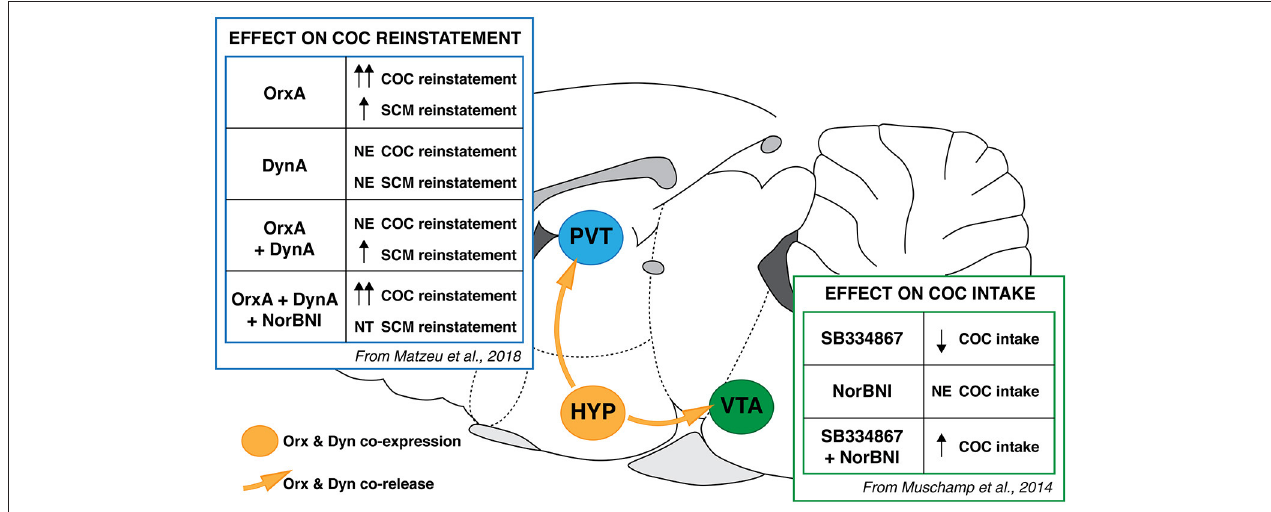
FIGURE 3 | Schematic summary of Orx and Dyn interaction in COC-directed behaviors in the PVT and VTA. (PVT) In rats, OrxA injection in the PVT reinstated COC- and SCM-seeking behavior, with a greater effect in COC animals. DynA blocked OrxA-induced COC seeking but not SCM seeking. nor-Binaltorphimine (nor-BNI) did not induce or potentiate COC-seeking behavior that was induced by OrxA but reversed the effect of DynA (183). (VTA) Intra-VTA administration of SB334867 reduced COC self-administration in rats. nor-BNI administration alone had no effect but reversed the effect of SB334867 (181). PVT, paraventricular nucleus of the thalamus; VTA, ventral tegmental area; NE, no effect; NT, not tested.